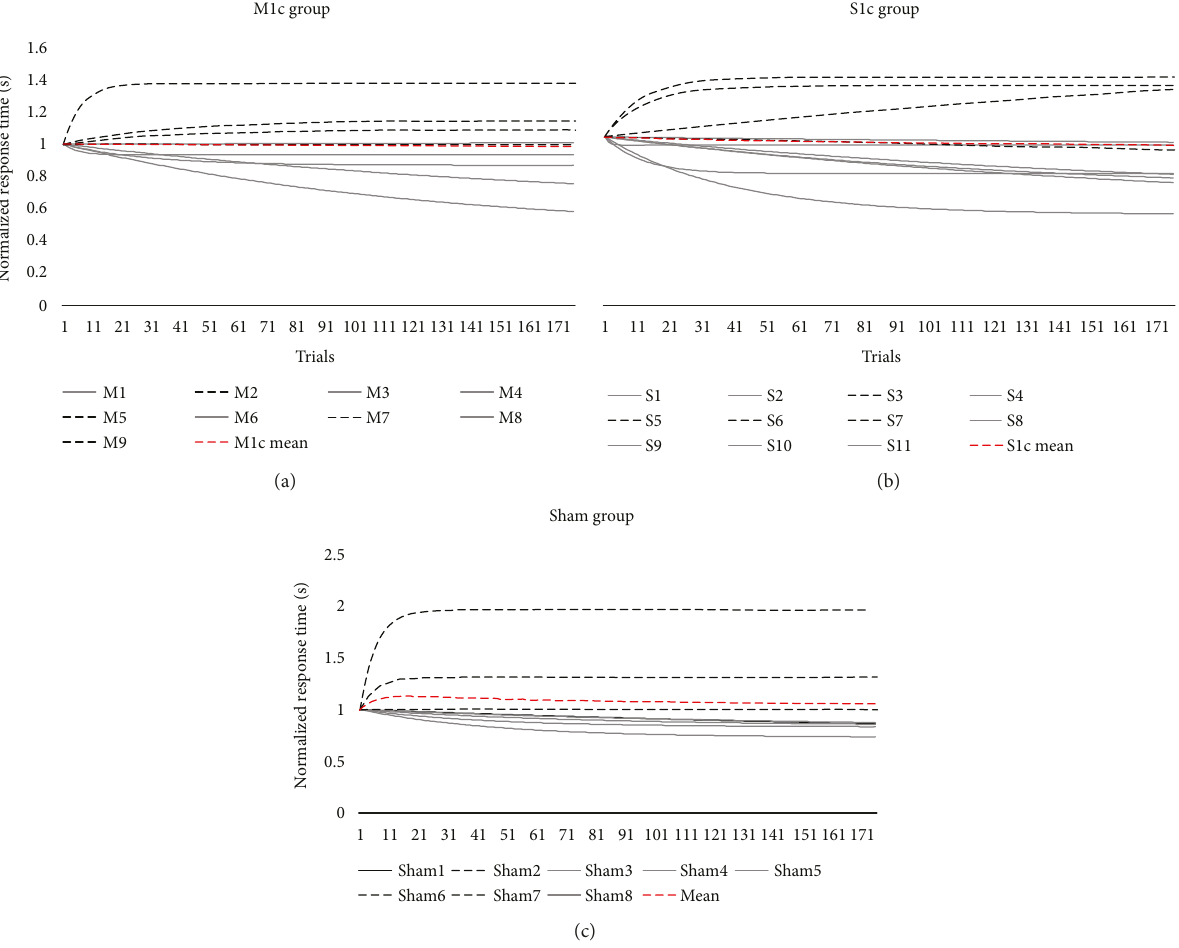
Figure 6: (a, b, and c) Motor skill acquisition curves for S1c, M1c, and sham stimulation groups. Single-subject normalized motor skill exponential curves for active cTBS stimulation groups (top panel) delivered over the contralesional primary somatosensory (S1c; (a)) and contralesional primary motor cortex (M1c; (b)) and for the sham stimulation group (bottom panel; (c)). Dotted black line indicates individuals with negative B scores and identi fi ed as motor skill nonresponders. Solid grey line indicates individuals with positive B scores and identi fi ed as motor practice responders. Dashed red line represents the mean motor skill acquisition curve for each stimulation group. Table 4: Comparison (mean and SD) of responder versus nonresponder DWI characteristics in the SMc-cTBS group. Responders DWI